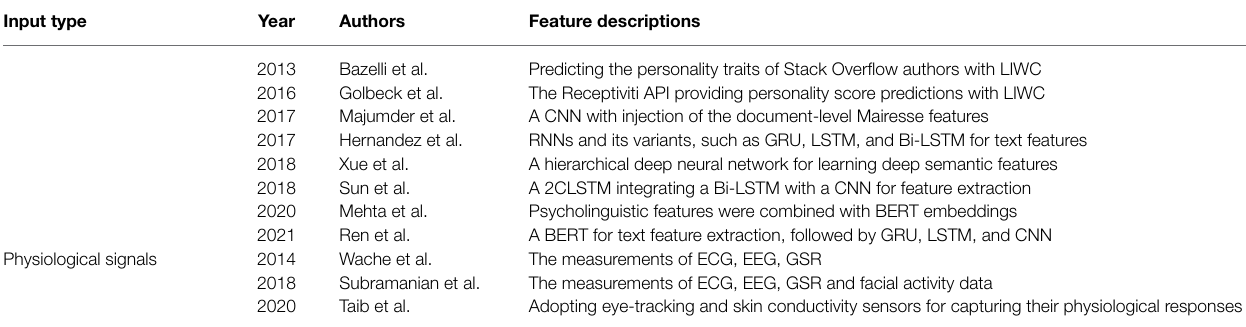
TABLE 5 | A brief summary of text and physiological-based personality trait recognition. Input